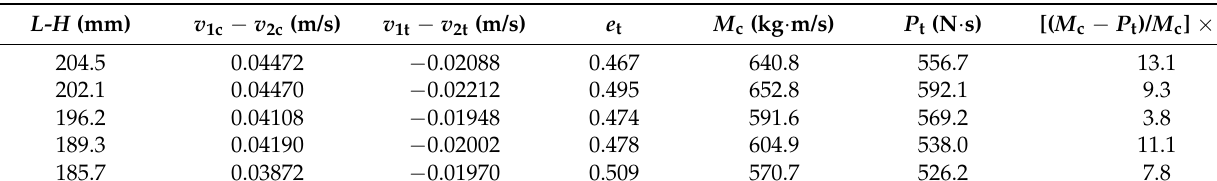
Table 2. Results of the experiments of the DBoBSI in ISD system.